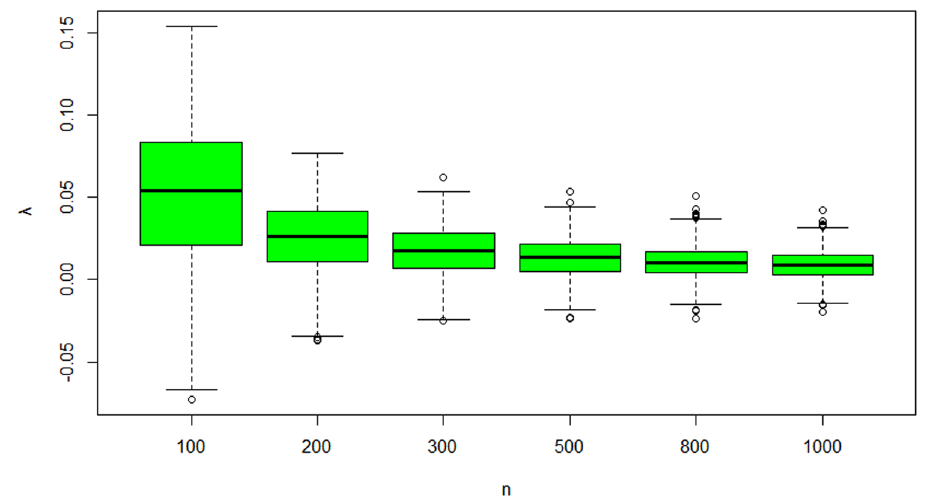
Figure 7: Boxplots